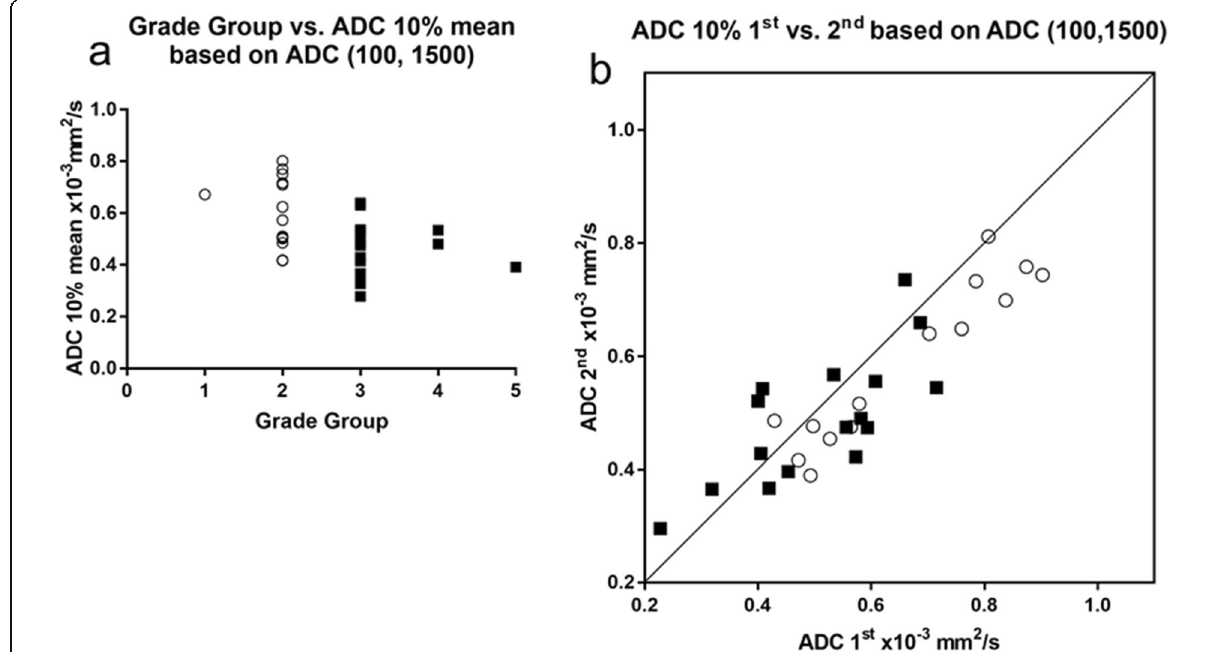
Fig. 4 Peripheral zone cancer. a Correlation between grade group and mean of the first and second apparent diffusion coefficient (ADC) 10% based on ADC (100, 1,500). b XY plot of the first and second ADC 10% based on ADC (100, 1,500). Open circle, closed square, and line indicate grade group (GG) of 1 and 2, GG of 3, 4, and 5, and Y = X line, respectively